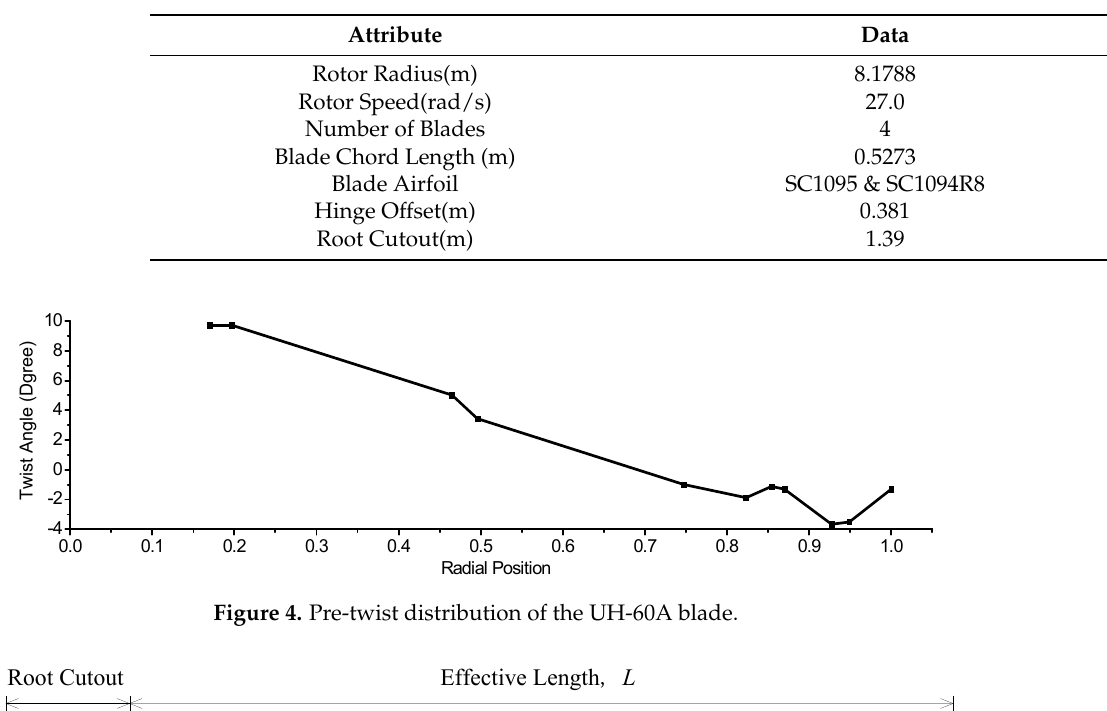
5 of 25 Figure 3. Forces and moments for the trim solution.